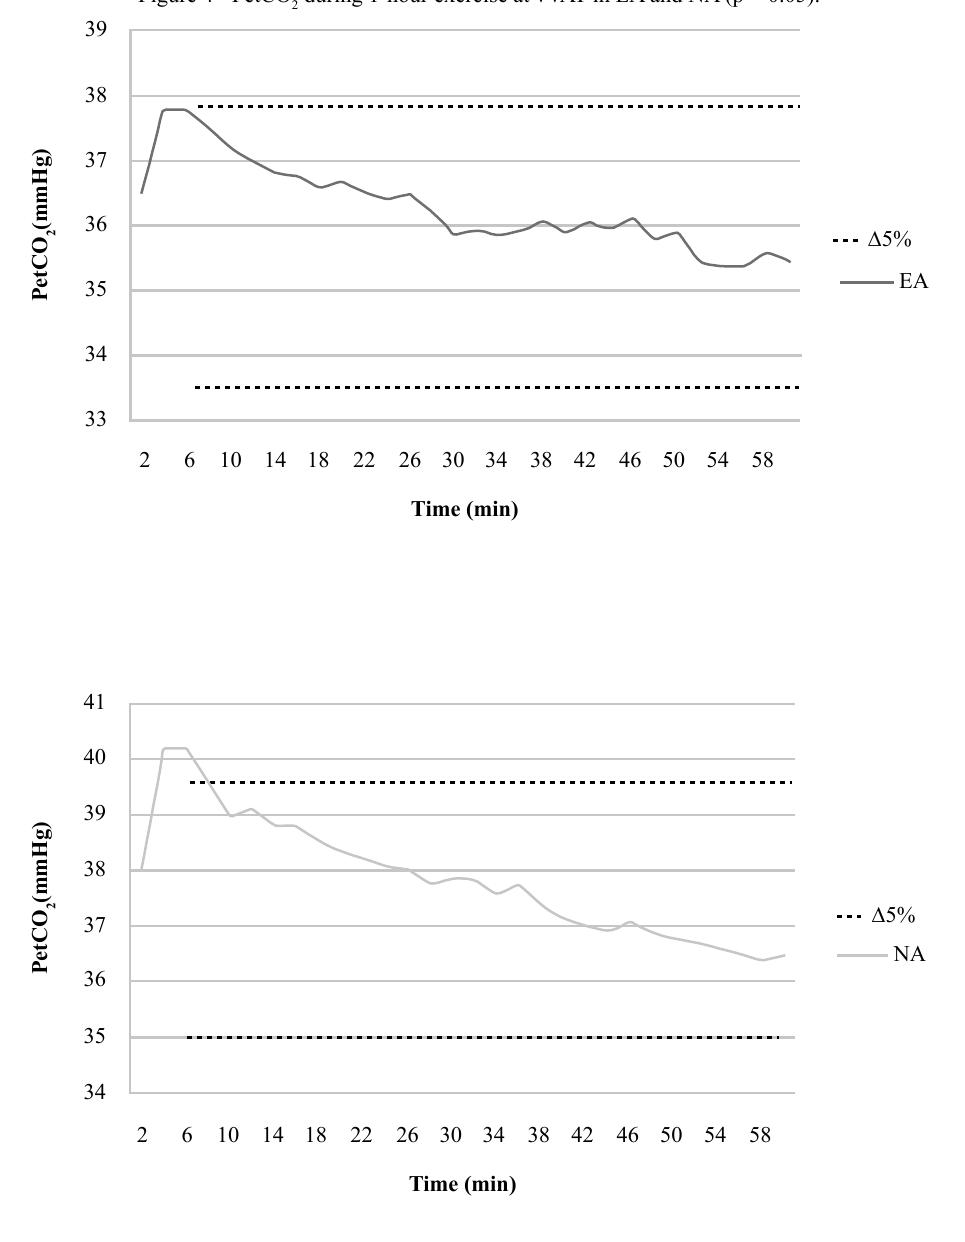
Figure 4− PetCO during 1-hour exercise at vVAT in EA and NA (p > 2